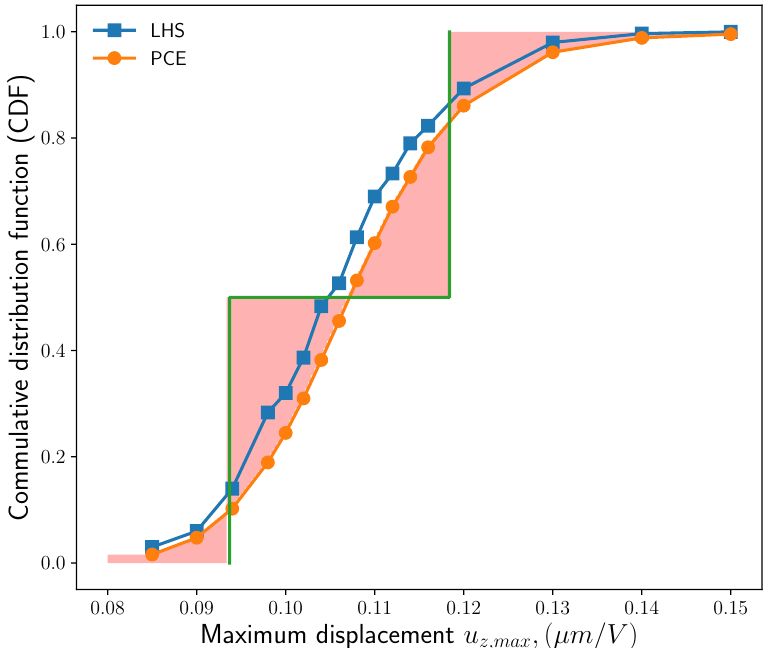
Figure 14. Cumulative distribution function of the maximum deflection response obtained from different UQ approaches. The green line is the CDF of the experiment constructed from two data points. The shaded area is the area validation